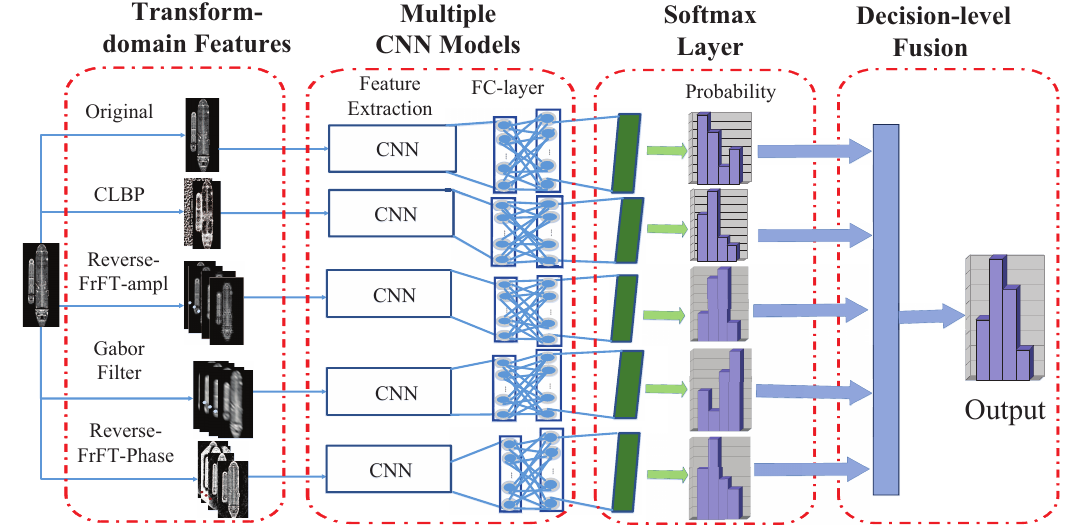
Figure 1. A flowchart of proposed classification framework in optical remote sensing